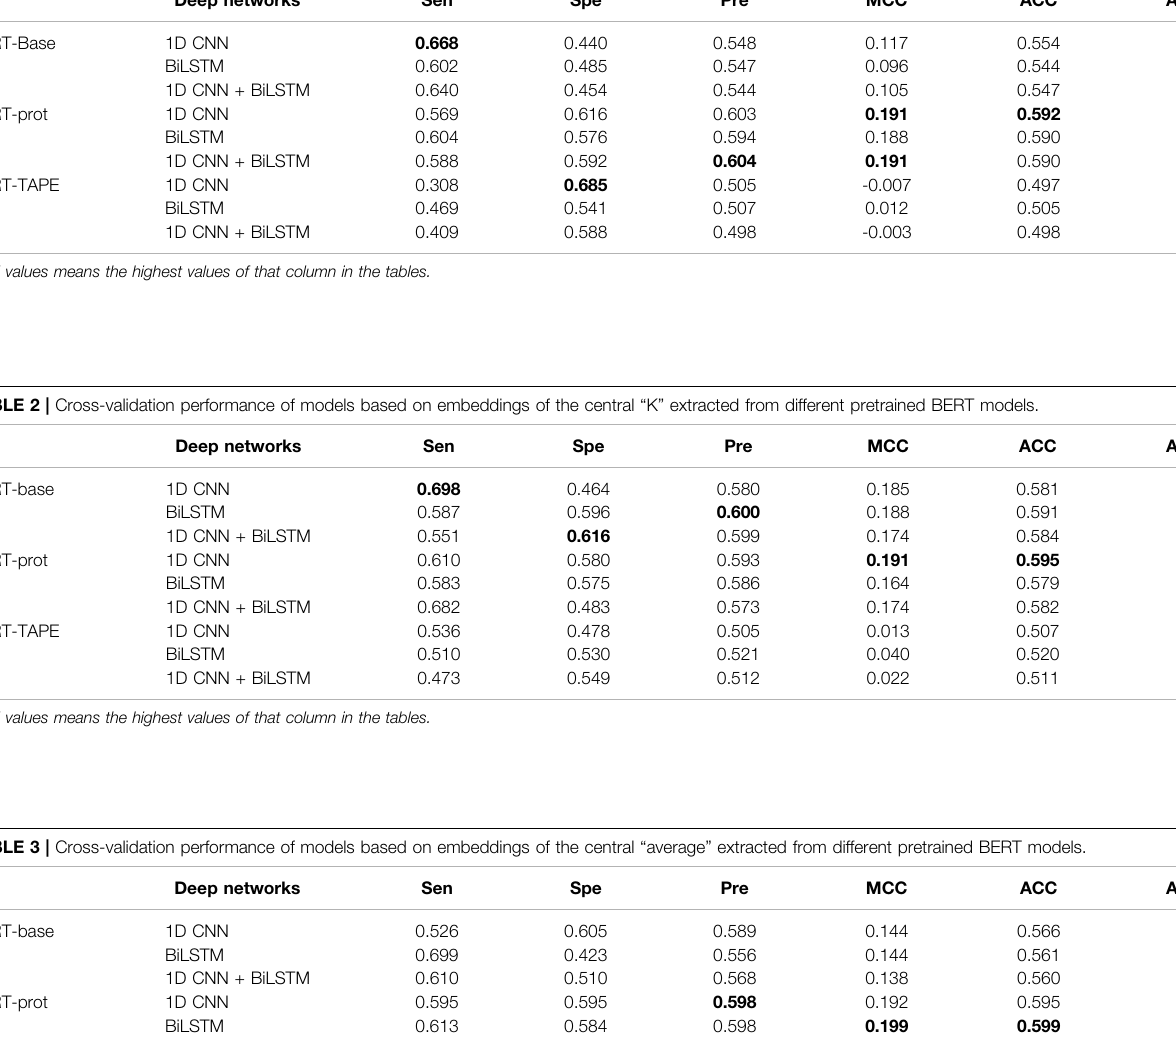
Bold values means the highest values of that column in the